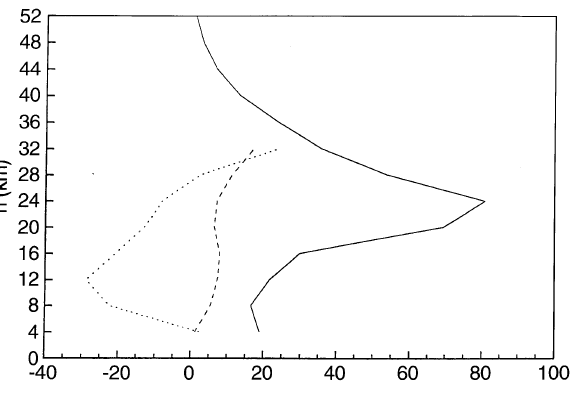
Fig. 11. 5 December 1993; solid line : O (cid:51) profile (10 (cid:49)(cid:49) molecu- lescm (cid:126)(cid:51) ); dashed line : zonal velocity profile (0.5 m s (cid:126)(cid:49) ); dotted line : meridional velocity profile (0.5 ms (cid:126)(cid:49) )